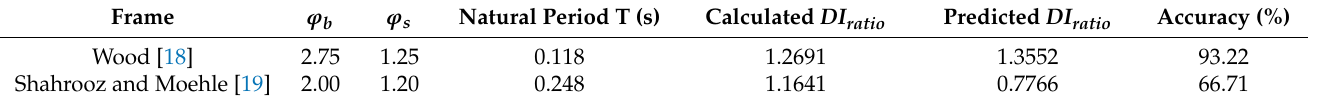
Table 6. Numerical analysis result compared to prediction result using Regression Equation. Frame ϕ b Natural Period T (s) Calculated DI ratio Predicted DI